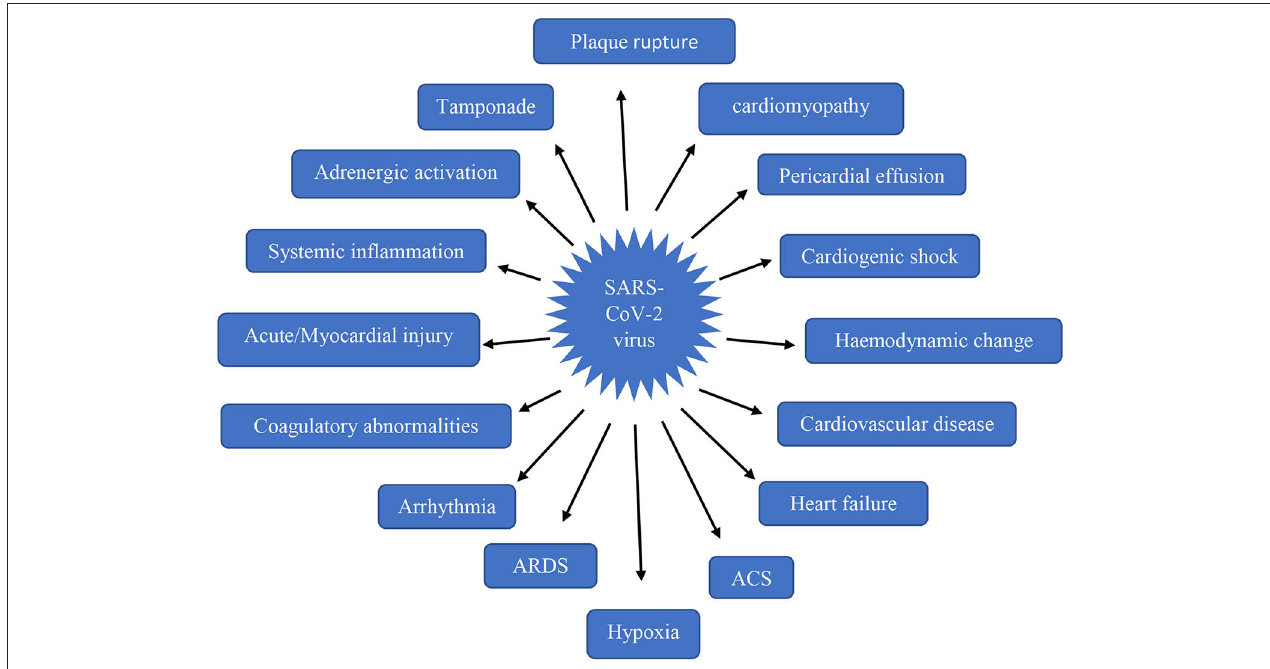
FIGURE 2 | Cardiovascular conditions associated with SARS-CoV-2